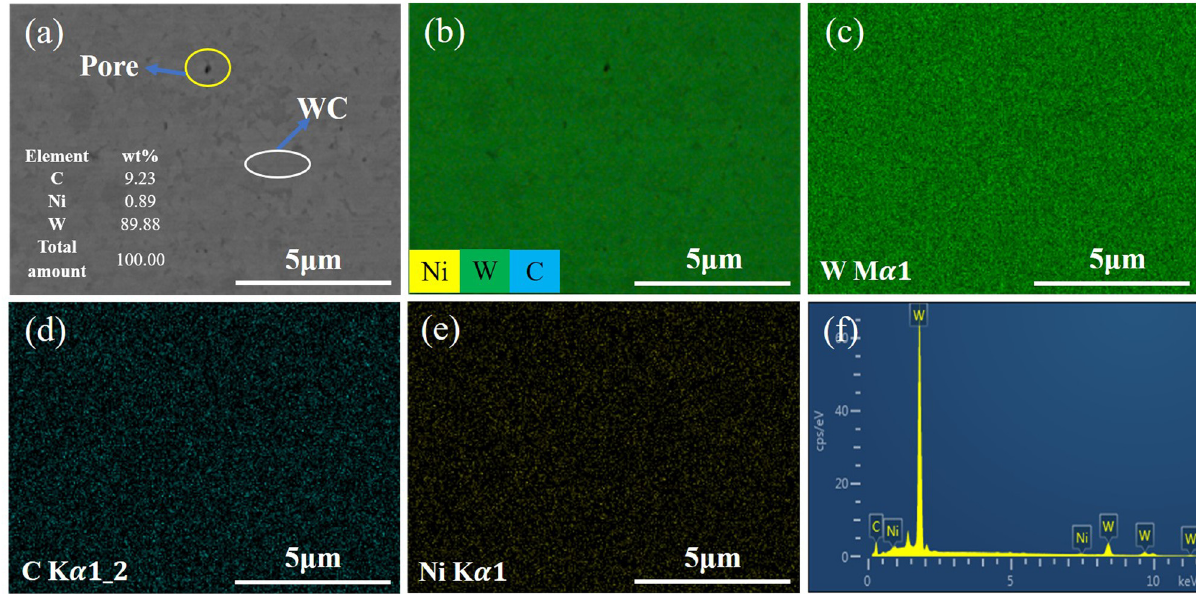
Figure 4: WCN - 6# backscatter topography and surface scanning map, ( a ) backscatter topography, ( b ) surface scanning map, ( c ) Element W, ( d ) Element C, ( e ) Element Ni, and ( f ) EDS results.